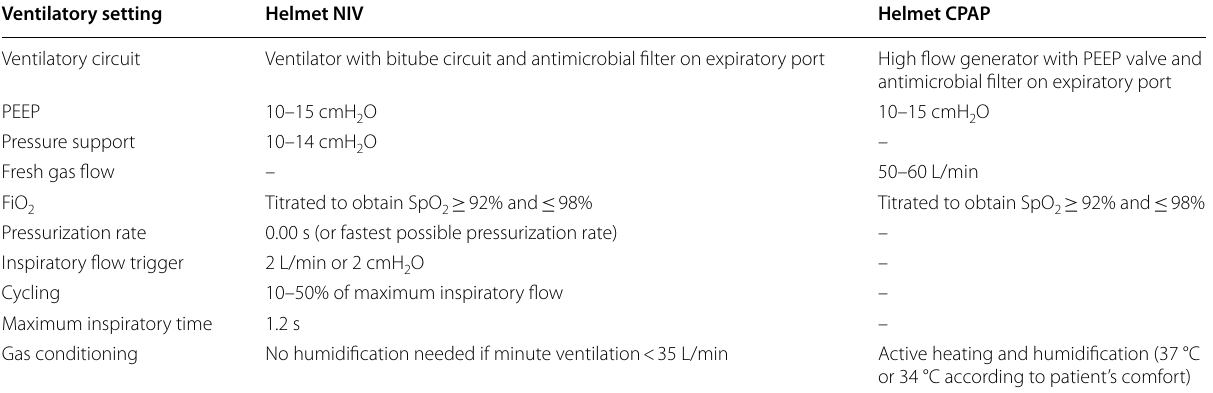
Table 1 Helmet settings in patients with acute hypoxemic respiratory, with and without pressure support Ventilatory